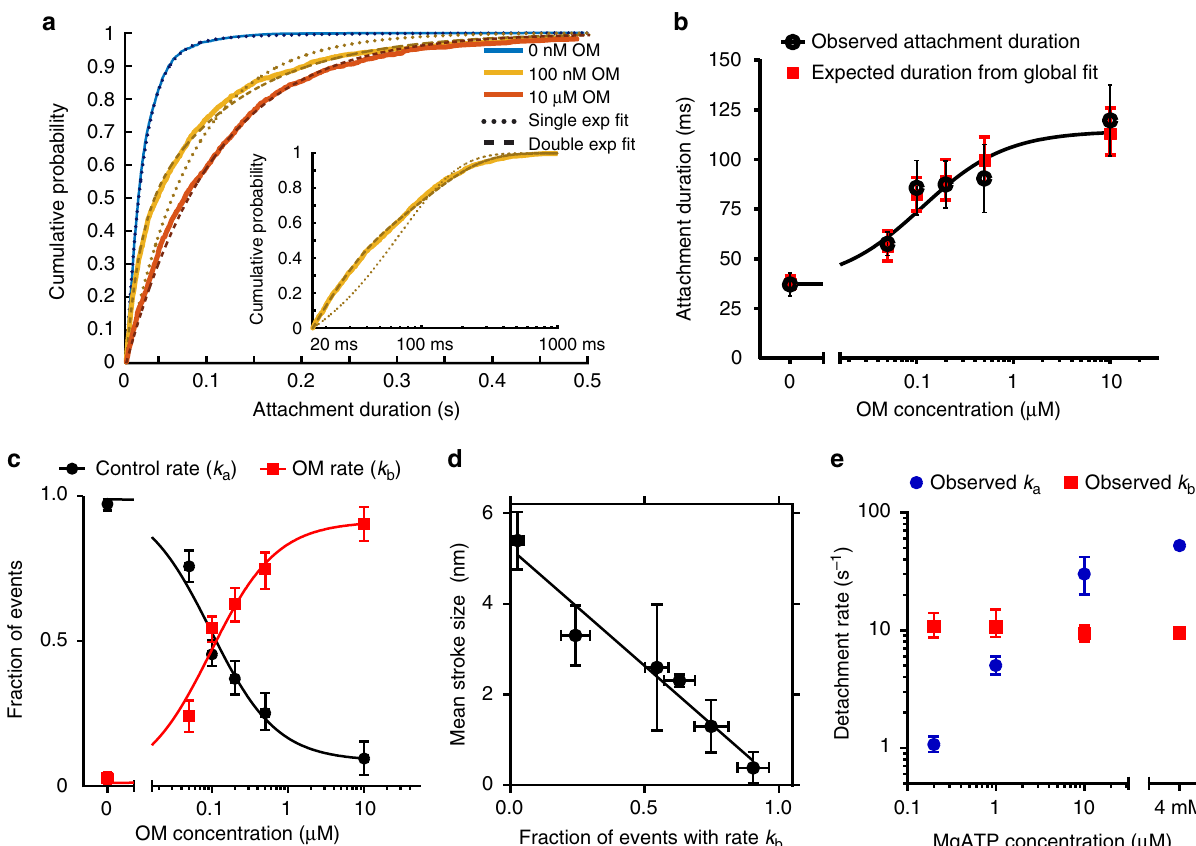
Fig. 3 Actin-attachment durations as a function of OM concentration. a Cumulative distributions of the actomyosin attachment durations (solid lines) at 4 mM MgATP. Without OM, the attachment durations are well-described by a single-exponential distribution (dotted blue line); however, at 100 nM and 10 μ M OM, double exponential distributions were required (yellow and red dashed lines). Inset: 100 nM OM durations on logarithmic x -scale, highlighting the two phases of detachment. b Concentration-dependent effect of OM prolonging the mean observed attachment duration (black) at 4 mM MgATP. Black error bars show the standard deviation of the mean durations from each molecule. Red squares show the expected duration calculated from the global fi t to durations. c The fraction of events which were found to detach at k a , (black), or at the OM-associated rate ( k b, red) from the durations global fi t as a function of OM concentration. d Observed step size linearly correlates with the fraction of events which detach at the OM-associated rate, k b . Vertical error bars are the standard deviation of the mean step from each molecule studied. e Detachment rates at 10 μ M OM as a function of MgATP concentration. Rate k a (blue) was proportional to MgATP concentration at low ATP concentrations. Rate k b (red) was only observed in the presence of the drug and was independent of the ATP concentration at all concentrations studied. Unless otherwise noted, error bars from all panels show the 95% con fi dence intervals obtained via bootstrapping. N -values are presented in Supplementary Table